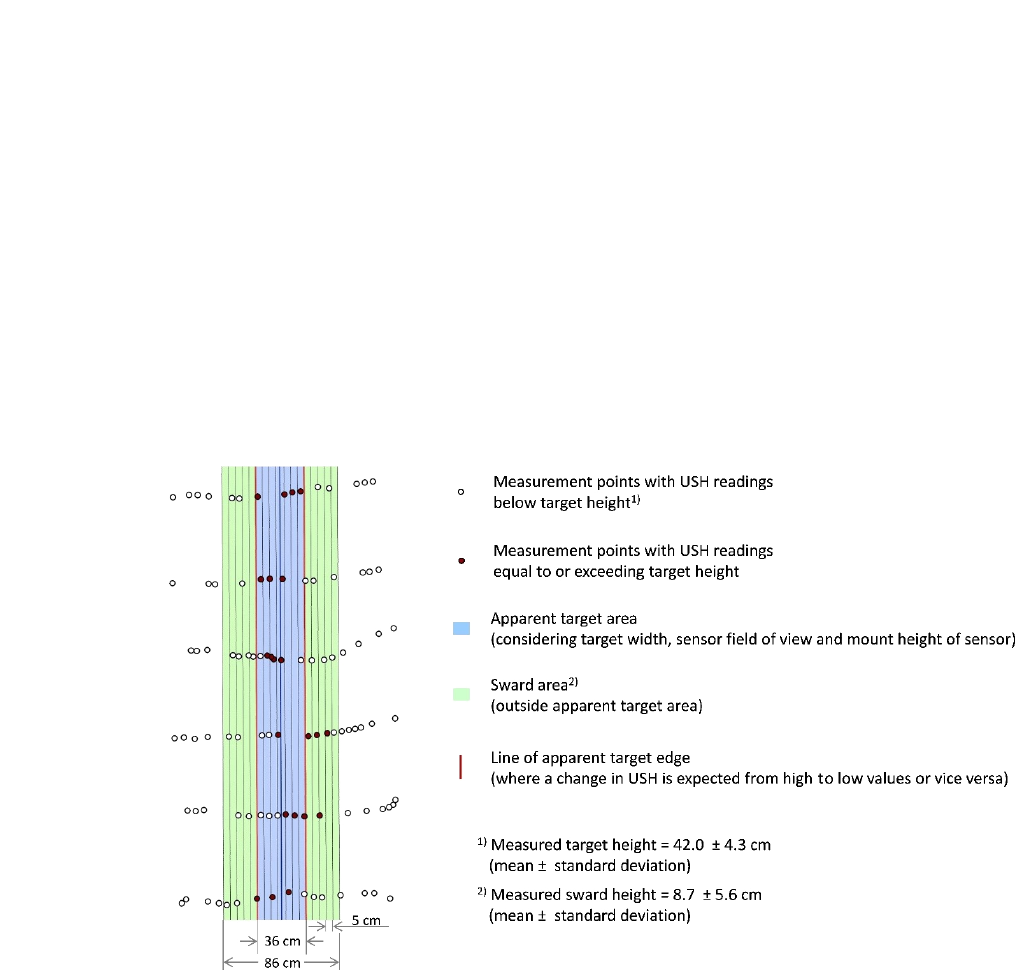
Figure B3. Locations of measurement points with USH readings generated by vehicle-mounted sensors during the passage of targets for determining position accuracy. The diagram exemplarily shows a 3 . 4 × 1 . 7m 2 map extract of the moderately stocked grassland paddock (see Fig.